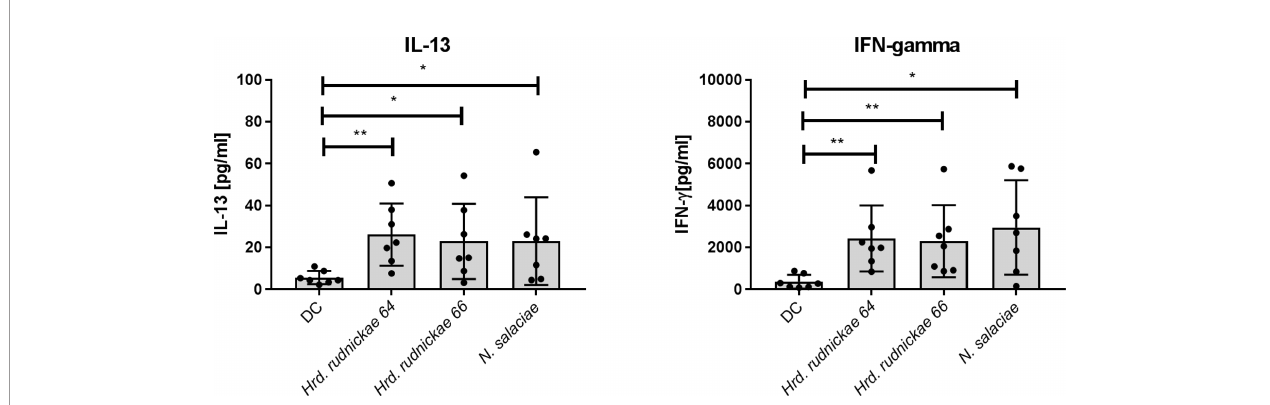
FIGURE 3 | Cytokine secretion by CD4 + T cells co-cultured with halophile-stimulated DCs. Secretion of IFN- g and IL-13 by human CD4 + T cells following 96 h co- culture with Hrd. rudnickae 64-, Hrd. rudnickae 66- or N. salaciae- pulsed autologous DCs (ratio DCs:T cells, 1:10) was measured in duplicates by ELISA. Data shown represent the means ± SD of 7 donors. Statistical analyses were performed using the Mann – Whitney U test for unpaired data . *p < 0.05; **p < 0.01 versus control (unstimulated